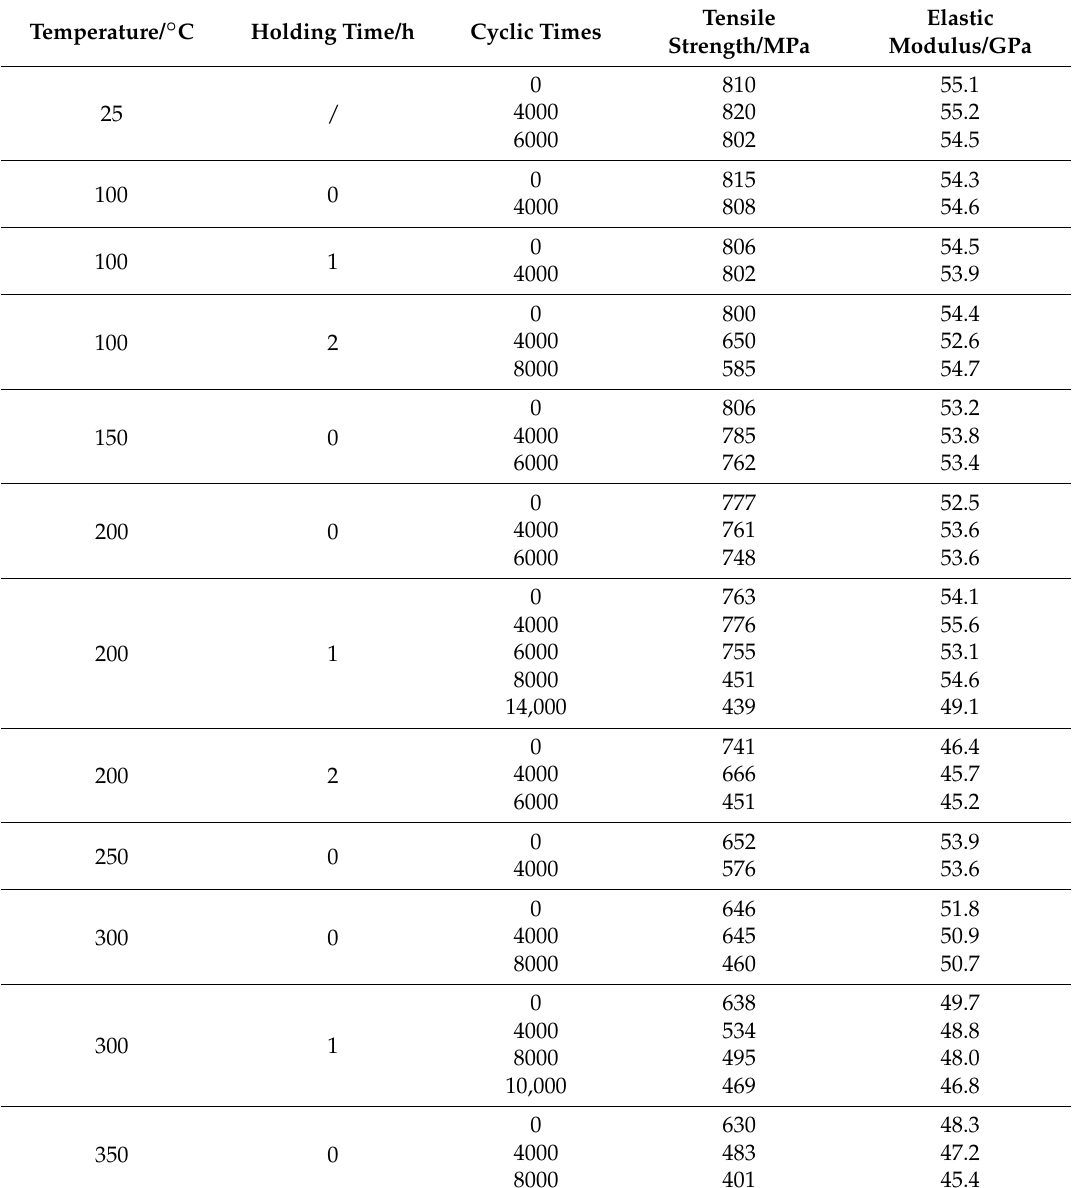
Table 3. The tensile results of GFRP bars after cyclic